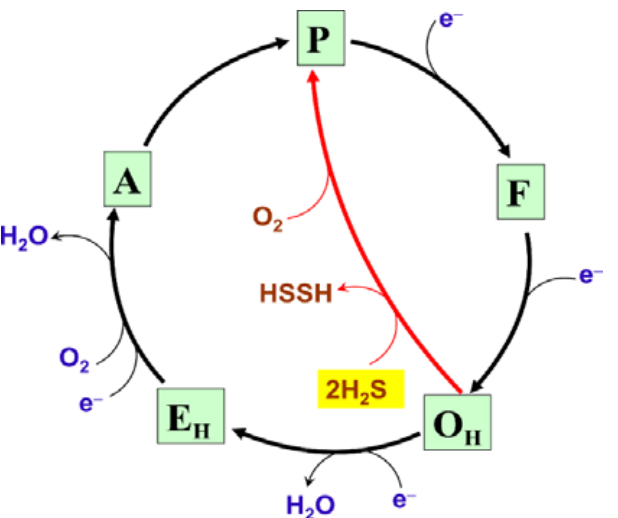
Figure 6. Proposed molecular mechanism of the reaction of the fast form of mitochondrial cytochrome c oxidase with low H 2 S levels. O H , E H , A, P, and F are unrelaxed oxidized, unrelaxed one-electron- reduced, compound ‘A’, compound ‘P’, and compound ‘F’ catalytic intermediates, respectively. Chemical and pumped protons involved in the catalytic cycle are not shown for